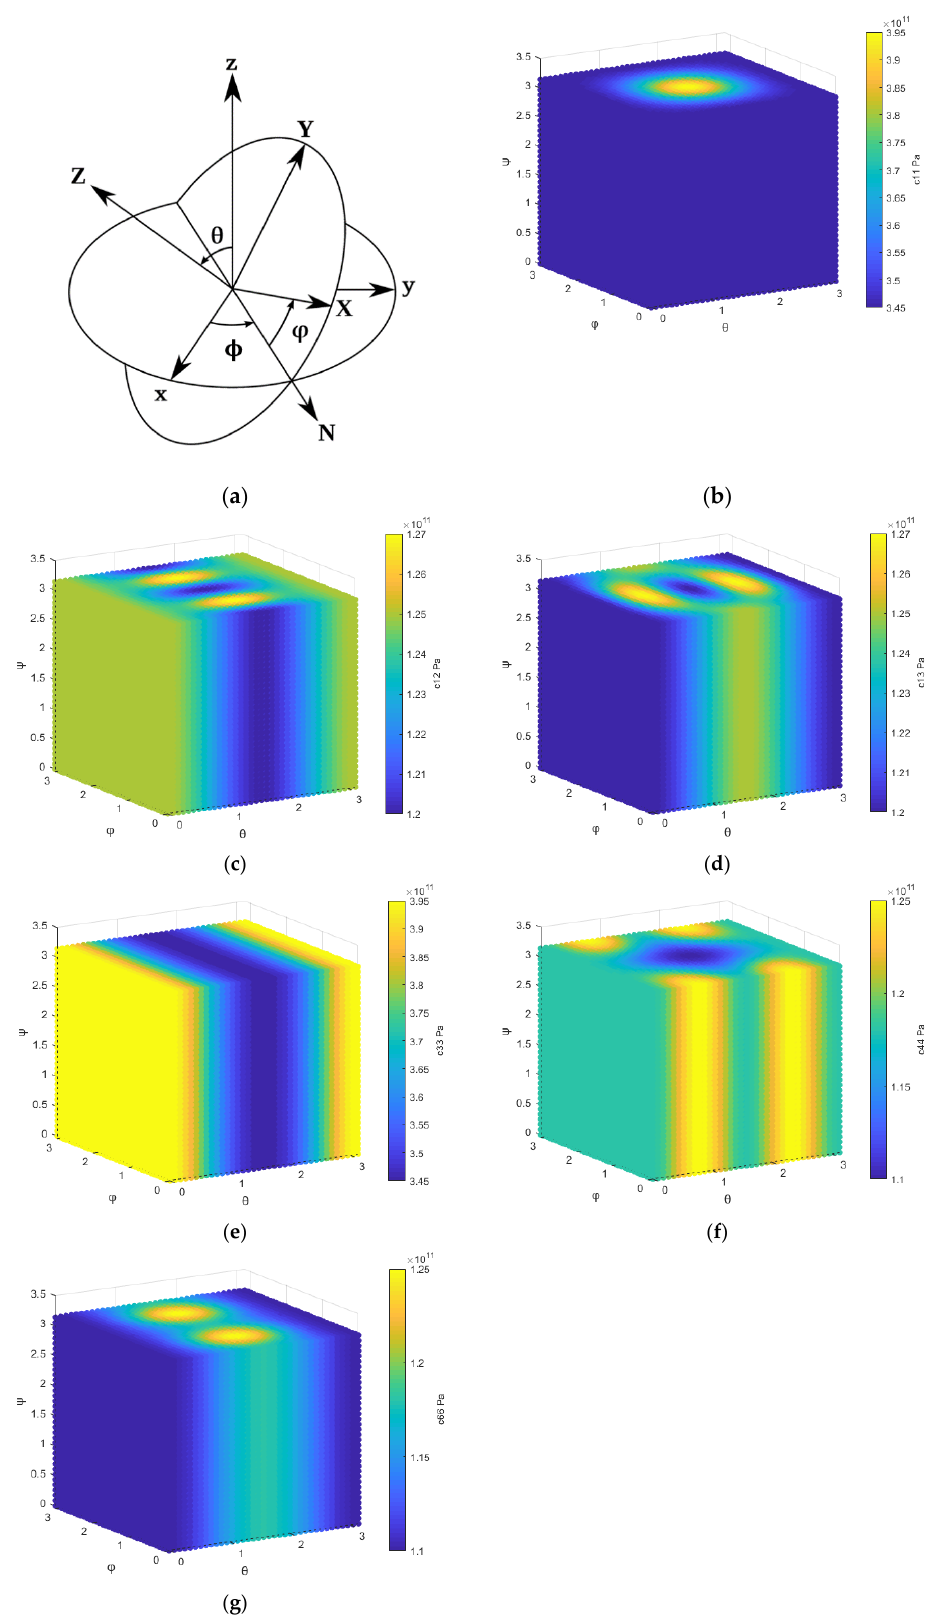
Figure 7. ( a ) Euler angle for right-hand axis system. Numerical distribution of the independent components of the elastic stiffness ([ c ij ]) in the Euler angle space, which are ( b ) c 11 , ( c ) c 12 , ( d ) c 13 , ( e ) c 33 , ( f ) c 44 and ( g ) c 66 ,